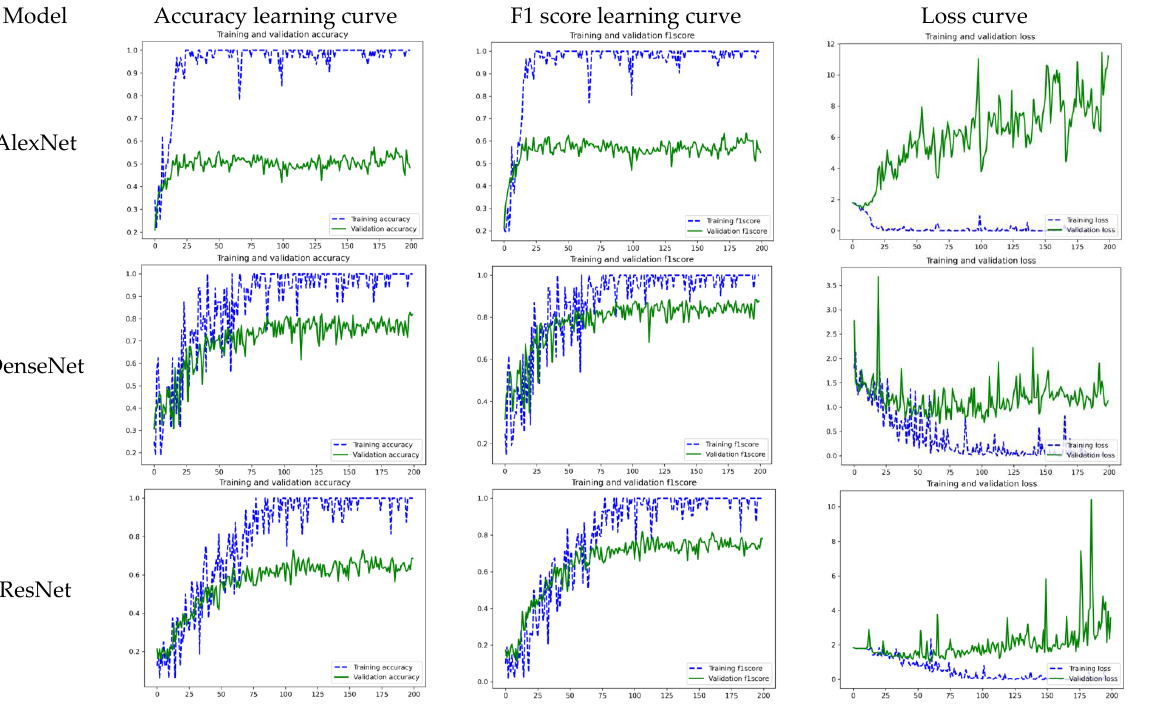
Figure 6. Accuracy, F1 score, and loss learning curve for the representative CNNs, including AlexNet, DenseNet, and ResNet.